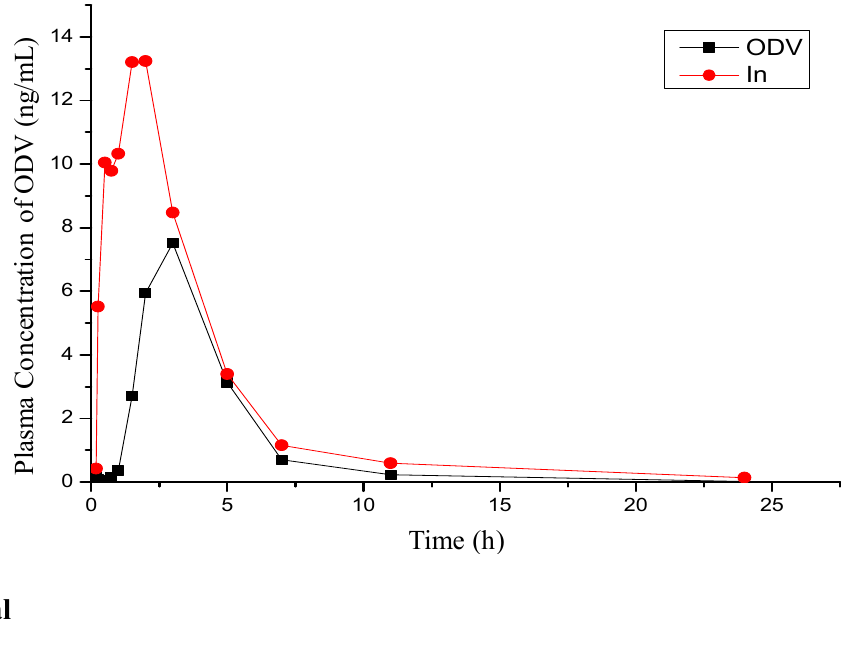
Figure 4. Mean plasma concentration-time profiles of ODV in a cross-over study involving oral administration of compound 1n and ODV at a dose of 0.007 mmol/kg to a group of beagle dogs (data are means, n =